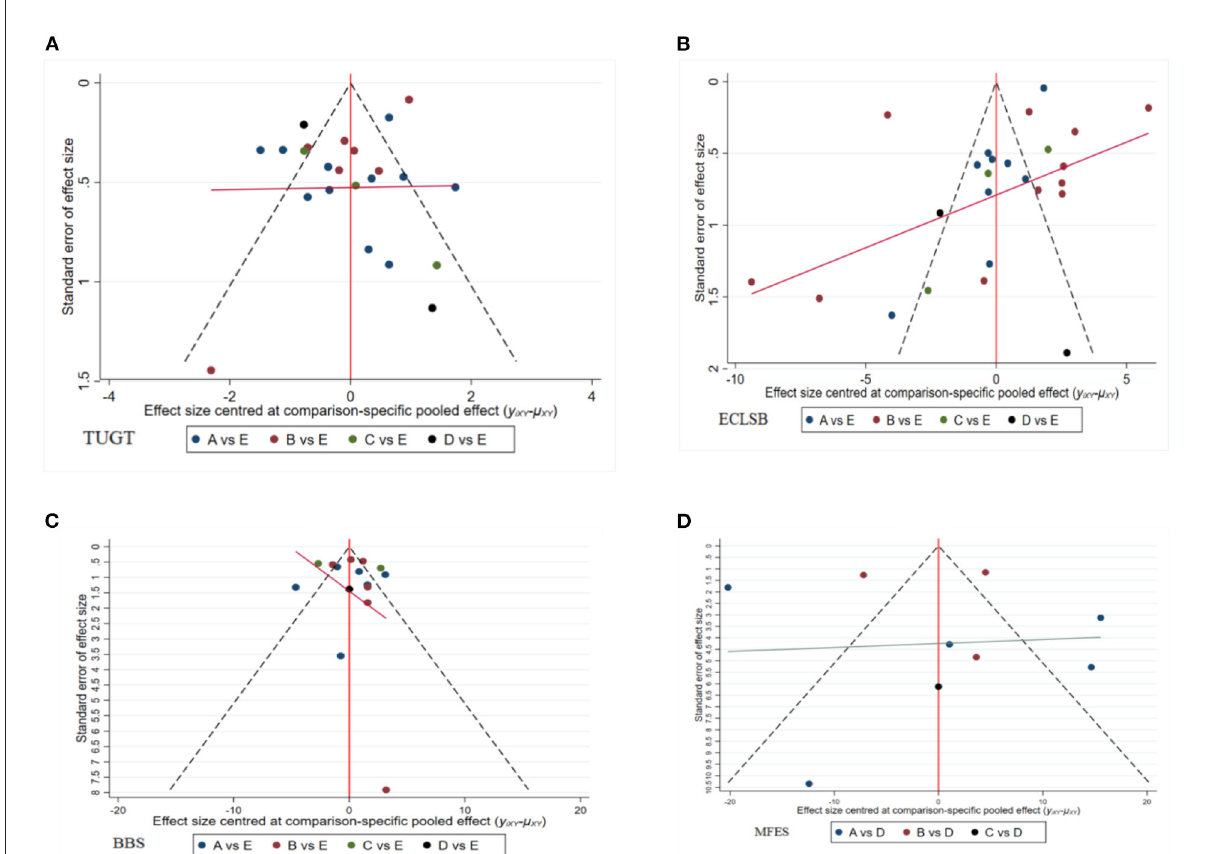
FIGURE11 Publication bias of four Chinese traditional exercises on TUGT, ECLSB, BBS, MFES. (A) TUGT; (B) ECLSB; (C) BBS; (D) MFES. In the picture, A is Ba Duan Jin, B is Tai Chi, C is Wu Qin Xi, D is Yi Jin Jing, and E is routine